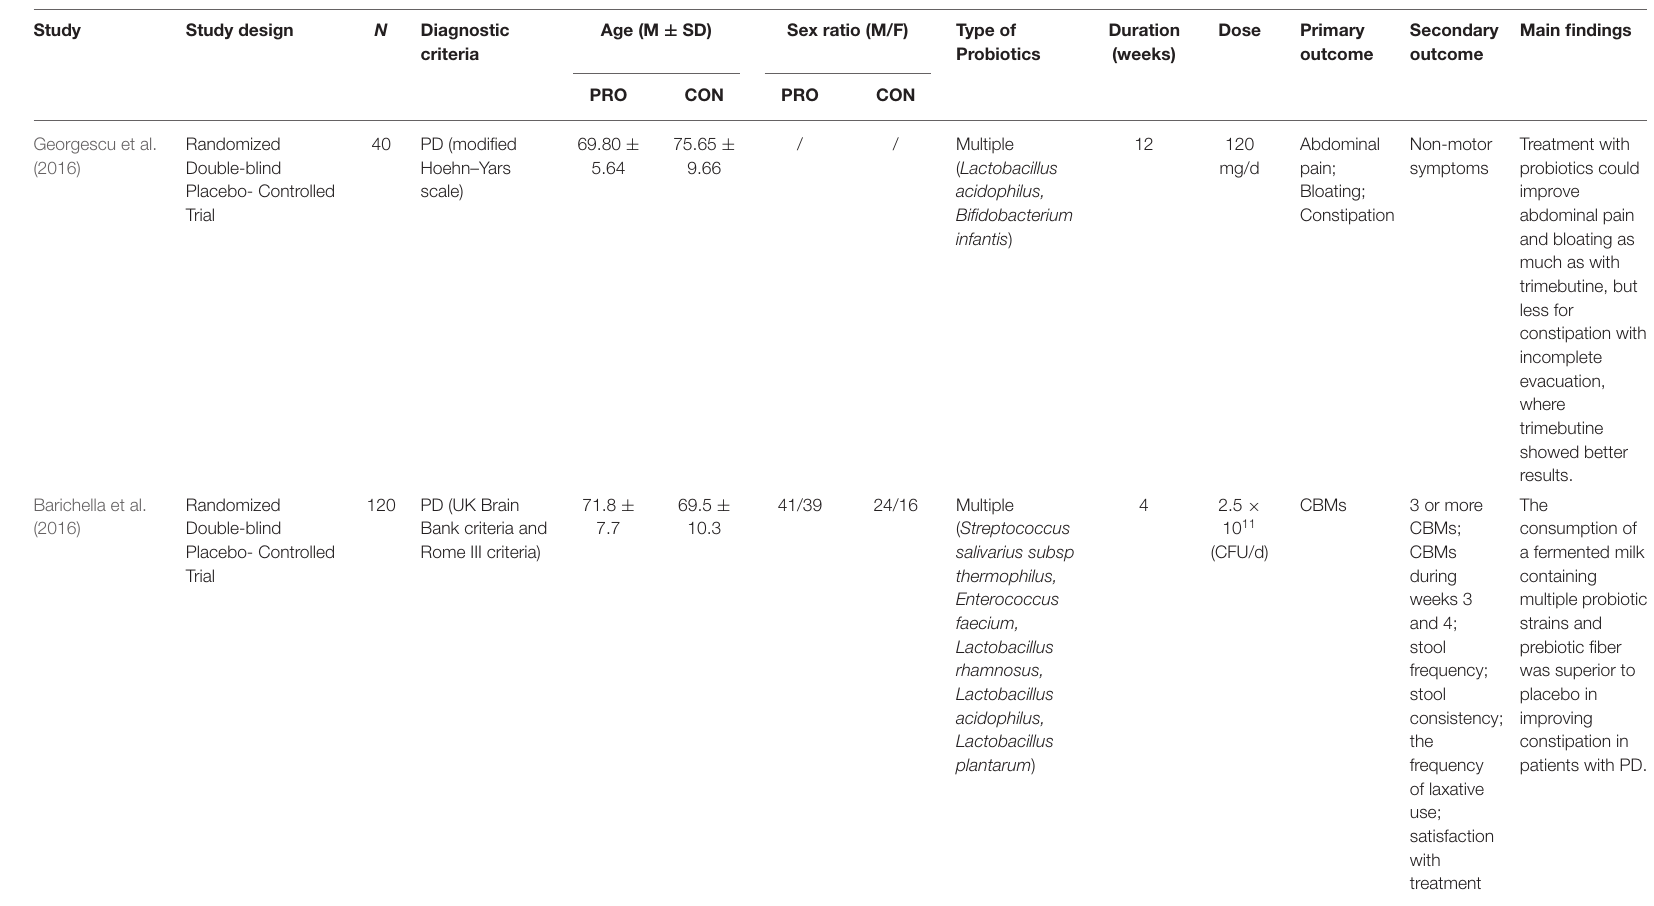
TABLE 2 | Main characteristics of the included PD